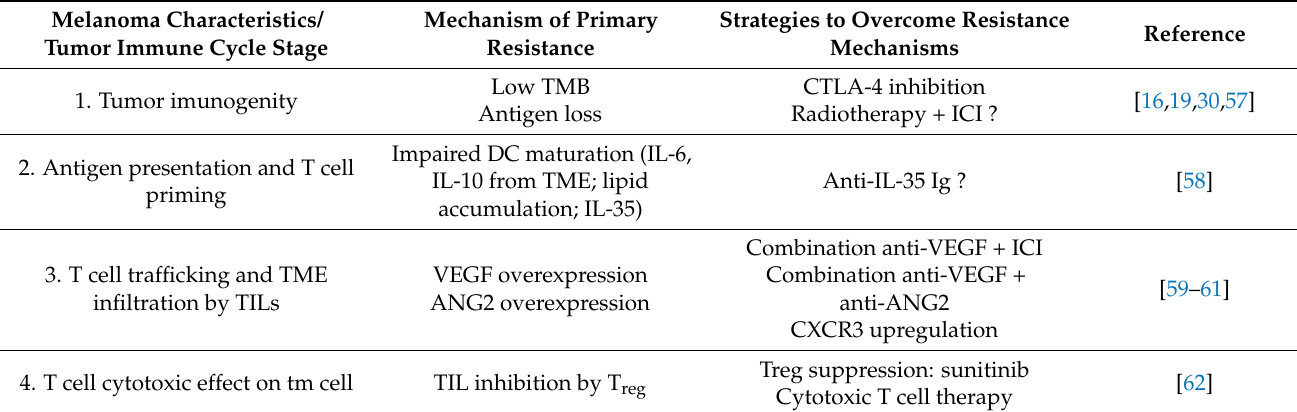
Table 2. Mechanisms of primary resistance to ICI